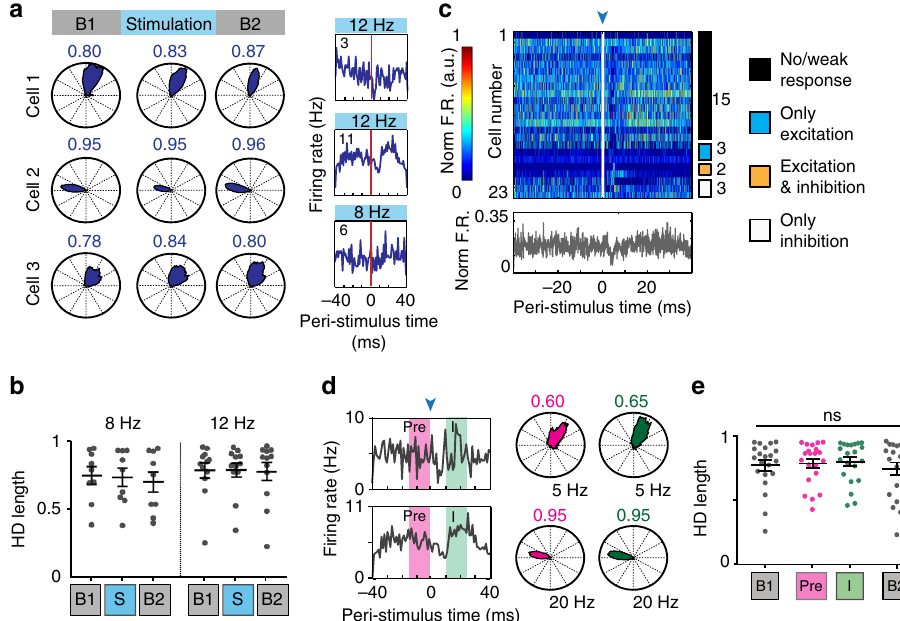
Fig. 5 Narrow HD cells only weakly responded to optical LIIP activation. a Example narrow HD cells maintained their directional tuning and at most weakly responded to LIIP stimulation (shown in the rightmost plot). The HD score (i.e., mean resultant length of HD tuning) is indicated above each polar plot. b There was no reduction in HD score for 8 and 12 Hz stimulation sessions [two-way ANOVA with repeated measures on one factor, n.s. interaction, n = 9 cells for 8 Hz, 12 cells for 12 Hz across 6 mice, F (2,38) = 0.3363, p = 0.7165]. c Peri-stimulus time plot for all HD cells. Cells are ordered by their optogenetic response category with the number of cells in each category indicated to the right. Most narrow HD cells showed weak or no response to the optic stimulation, as can also be seen from the mean normalized fi ring rate of all narrow HD cells. d HD tuning of two example cells when only spikes between 10 and 25 ms after light onset (I, green) and the same number of spikes between 15 and 0 ms before light onset (Pre, magenta) were included. e Quanti fi cation of HD tuning of all narrow HD cells revealed no difference between the two baseline sessions, and I and Pre windows [one-way repeated- measures ANOVA, n = 21 cells from 6 mice, F (2.199,43.97) = 2.493, p = 0.0894]. Plots in b , e show the mean ±